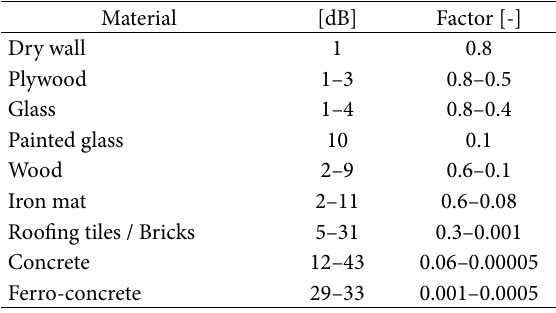
table 1. Attenuation of various building materials for the L-Band (L1 = 1500 MHz), according to Stone